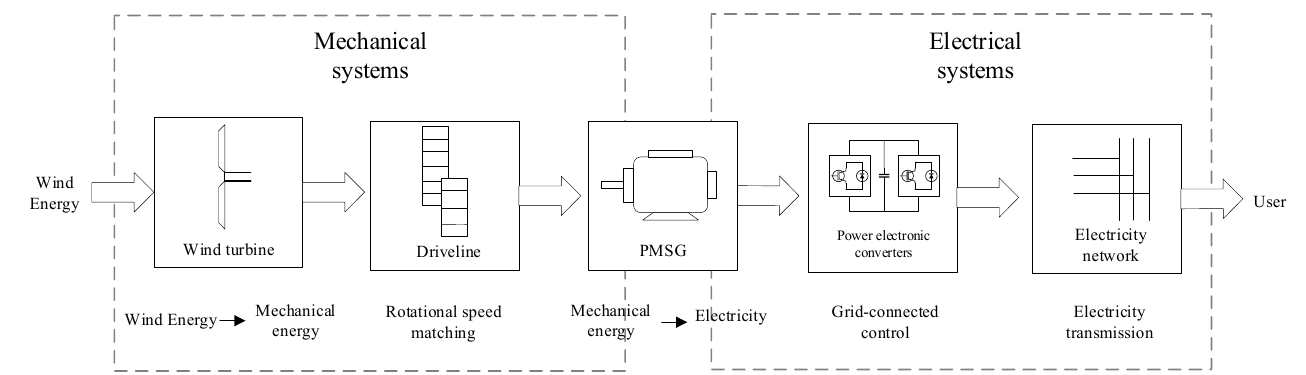
Figure 1. Structure of a permanent magnet synchronous wind power system.